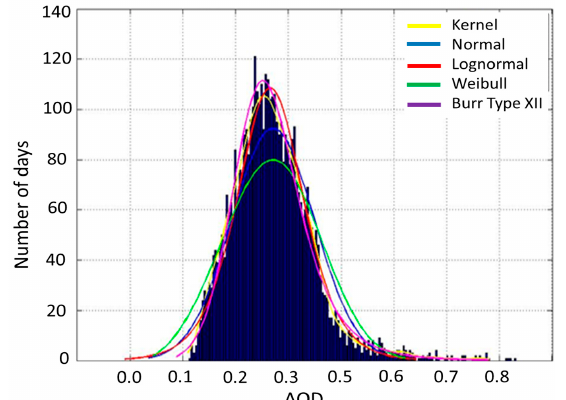
Figure 15. Histogram of AOD over Egypt. Measurements are compiled from the 12-year study period. Table 9. Goodness of fit measurement for data from Egypt and the five cities. The numbers in parentheses are ranks. Domain/Dist.